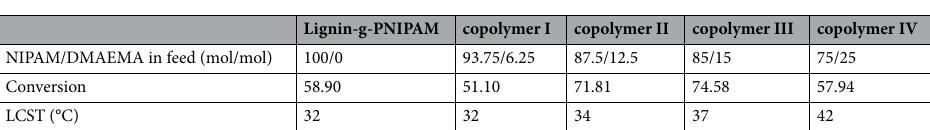
Table 1. Details of of lignin-based NGs synthesized in the present